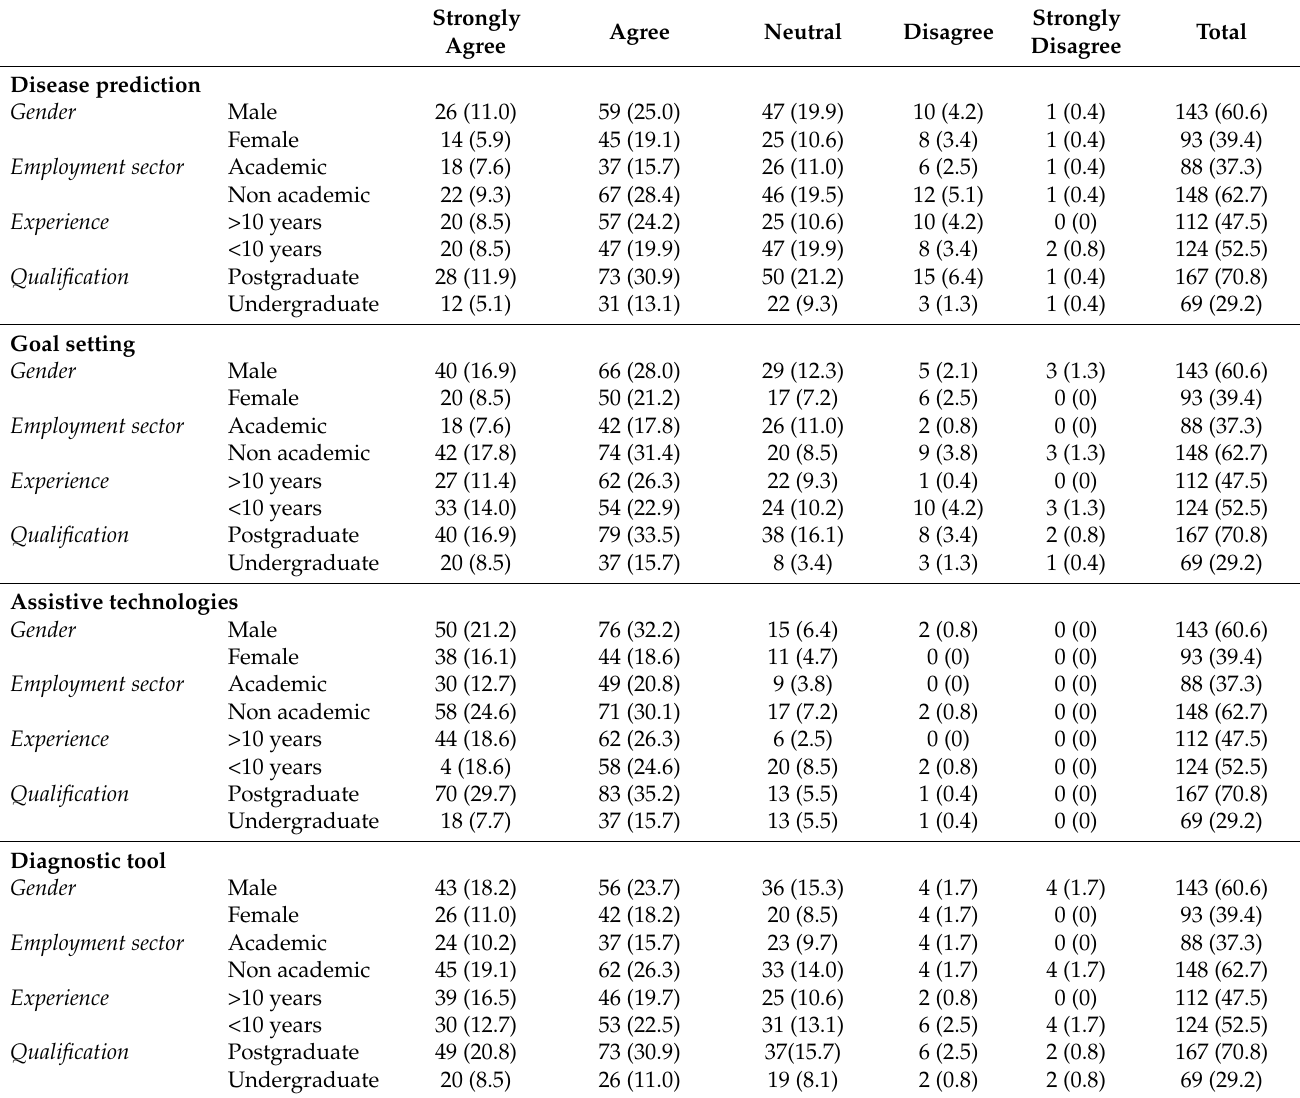
Table 5. Participants’ attitudes toward AI use in clinical